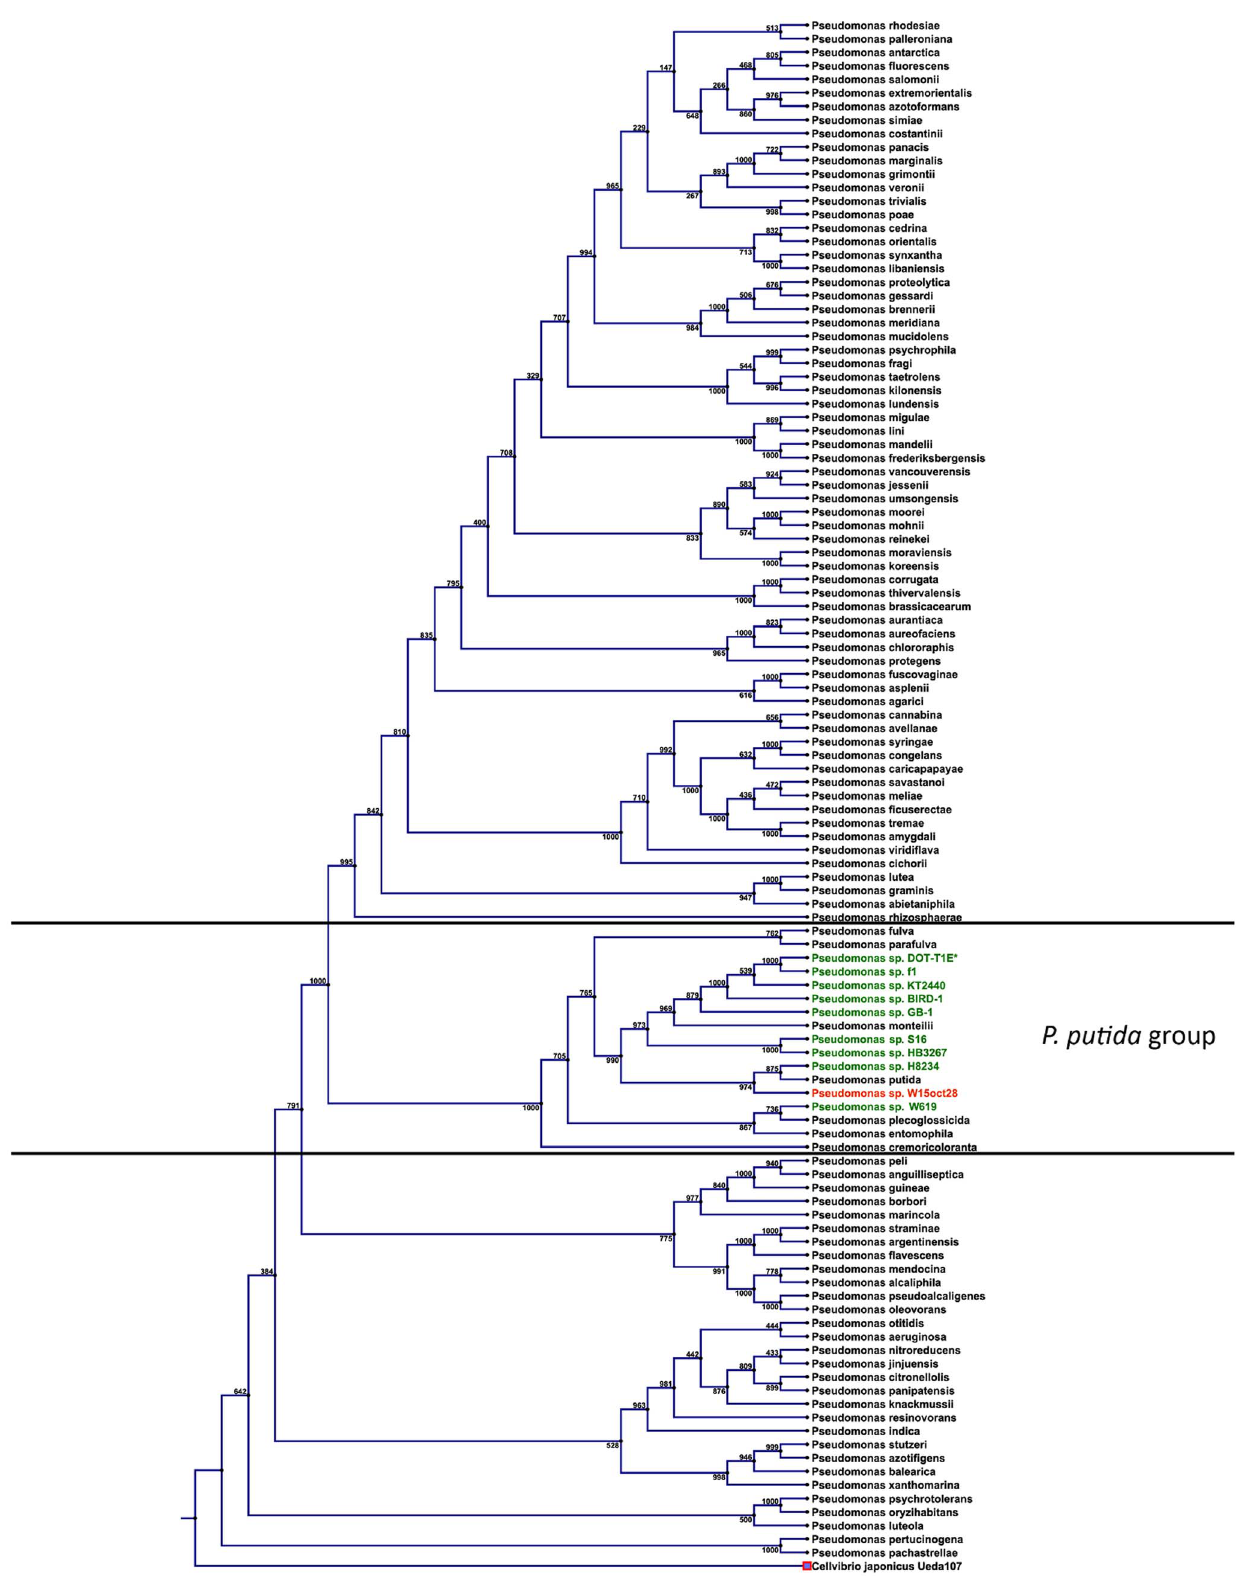
Figure 1. Pseudomonas phylogenetic tree. A phylogenetic tree of different Pseudomonas species based on the comparison of four different housekeeping genes sequences (16s rDNA, gyrB , rpoB , rpoD ). The P. putida cluster is highlighted and the strain W15Oct28 is indicated in red. W15Oct28 closest relative is the P. putida type strain NBRC14164 T .